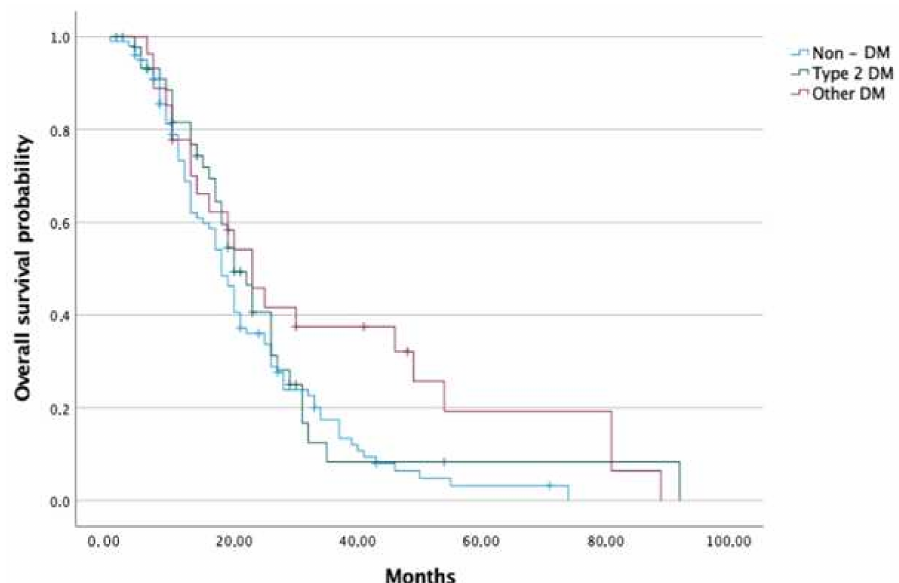
Figure 3. Overall survival of pancreatic cancer patients in the non-DM, T2DM and NODM